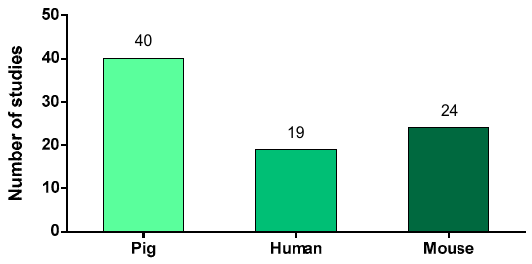
Figure 1. Distribution per target species of published studies addressing S. suis interactions with neutrophils or their role during S. suis infections. If more than one animal model was used in a study, it appears separately in the graphics. Source: PubMed ® (from October 1987 to August